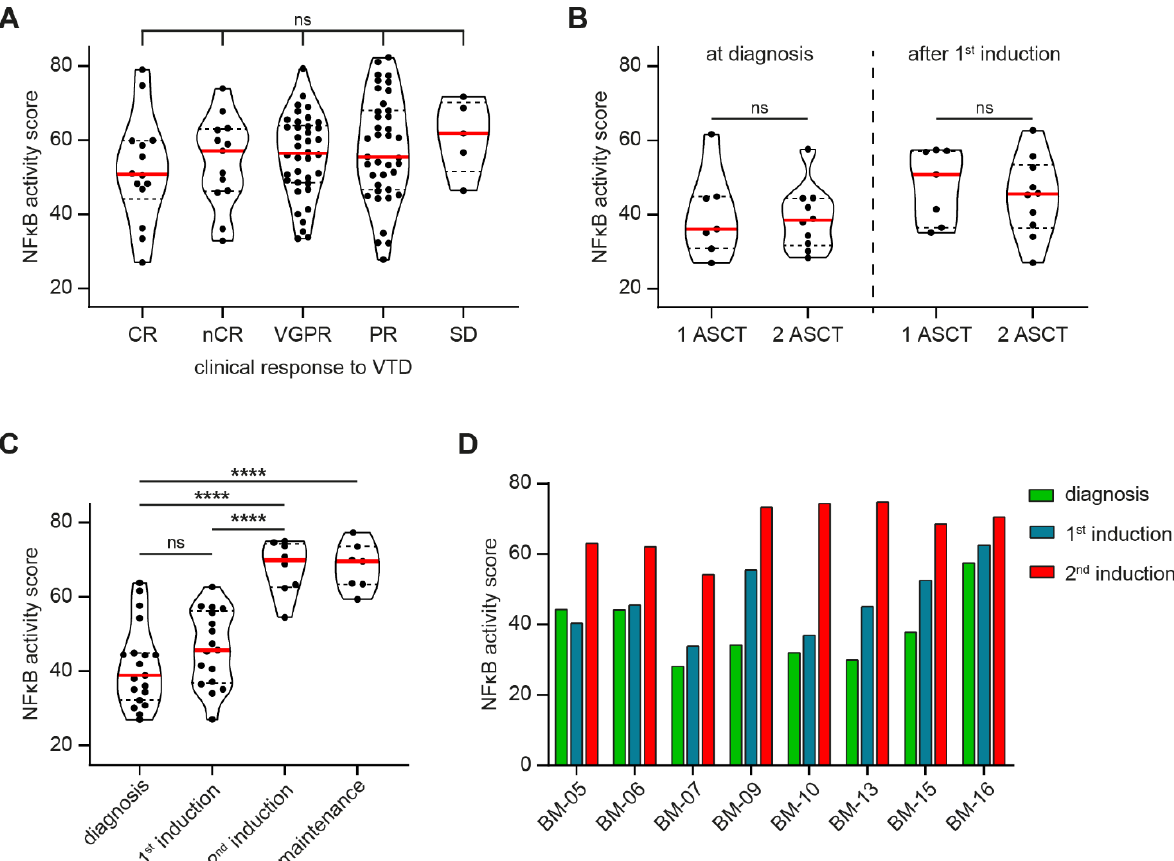
Figure 2. Violin plots showing the NF κ B activity score as analyzed by STA analysis in PC from ( A ) newly diagnosed MM patients with a quantified clinical response to subsequently administered first-line VTD (dexamethasone-thalidomide- bortezomib) induction therapy: complete response (CR), near-complete response (nCR), very good partial response (VGPR), partial response (PR), and stable disease (SD), as incorporated in dataset GSE68871; ( B ) MM patients at diagnosis, and after first-line chemotherapy-based induction therapy, that were stratified into two groups based on clinical response to subsequent total therapy: patients that required 1 ASCT, and patients that relapsed after the first ASCT and required a second ASCT (2 ASCT), as incorporated in dataset GSE19554; ( C ) MM patients at diagnosis, after first-line chemotherapy-based apy (maintenance), as incorporated in dataset GSE19554. Included samples are represented by individual data points, solid red lines indicate the median, and dashed lines indicate the quartiles of the population. ns, not significant, **** p < 0.0001. ( D ) Bar graph showing NF κ B activity score as analyzed by STA analysis in longitudinal PC samples of 8 individual MM patients at diagnosis, after first-line chemotherapy-based induction therapy prior to the first ASCT (1st induction), and after second-line chemotherapy-based induction therapy prior to the second ASCT (2nd induction), as incorporated in dataset GSE19554. BM, bone